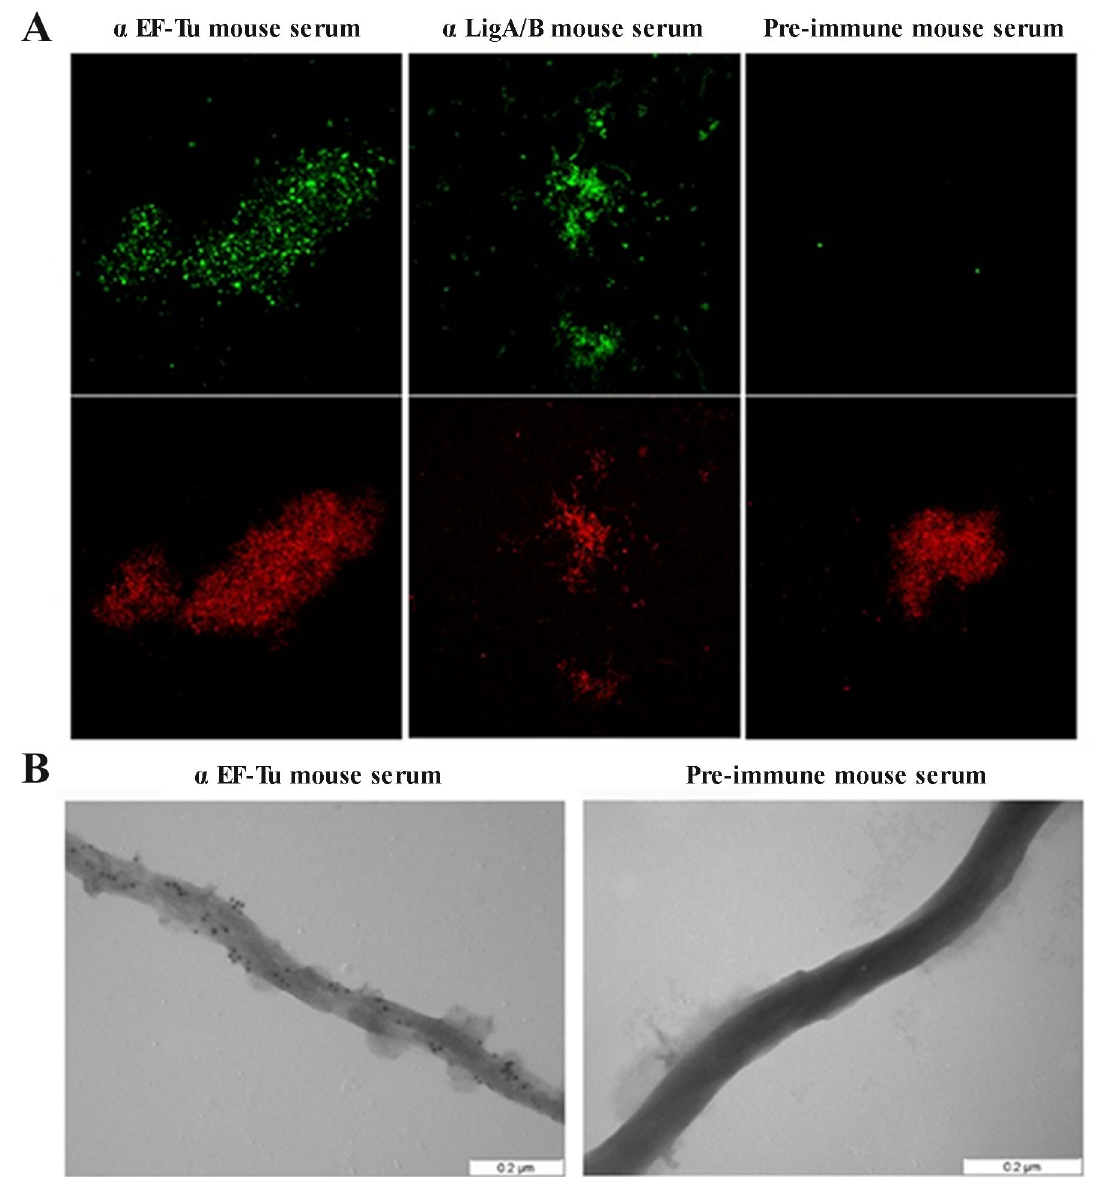
Figure 1. Cellular localization of EF-Tu on Leptospira interrogans . ( A ) Surface immunofluorescence assay was performed using confocal microscopy (Zeiss LSM-510 Meta). Intact leptospires were probed with anti-EF-Tu, anti-LigA/B or preimmune mouse serum. Alexa Fluor 488 conjugated goat anti-mouse IgG was used to detect bound antibodies. A iodide propidium counterstain (low panels) was used to demonstrate the presence of leptospires. ( B ) Immunoelectron microscopy analysis. Leptospires were incubated with anti-EF-Tu or pre-immune mouse serum, followed by treatment with colloidal-gold-conjugated anti-mouse IgG. Analysis was performed using an electron transmission microscope (LEO 906E - Leica Microsystems BmgH, Germany). doi: 10.1371/journal.pone.0081818.g001 (Figure 1A). EF-Tu surface localization was further assessed by immunoelectron microscopy. Immunogold labeling of L. interrogans cells was consistently observed with antiserum Once EF-Tu is associated to the leptospiral membrane, we against EF-Tu, while organisms incubated with preimmune next investigated its ability to interact with host molecules such serum did not present bound colloidal-gold particles (Figure as ECM and coagulation cascade components. According to 1B). our ELISA binding assays, EF-Tu interacted will all ECM